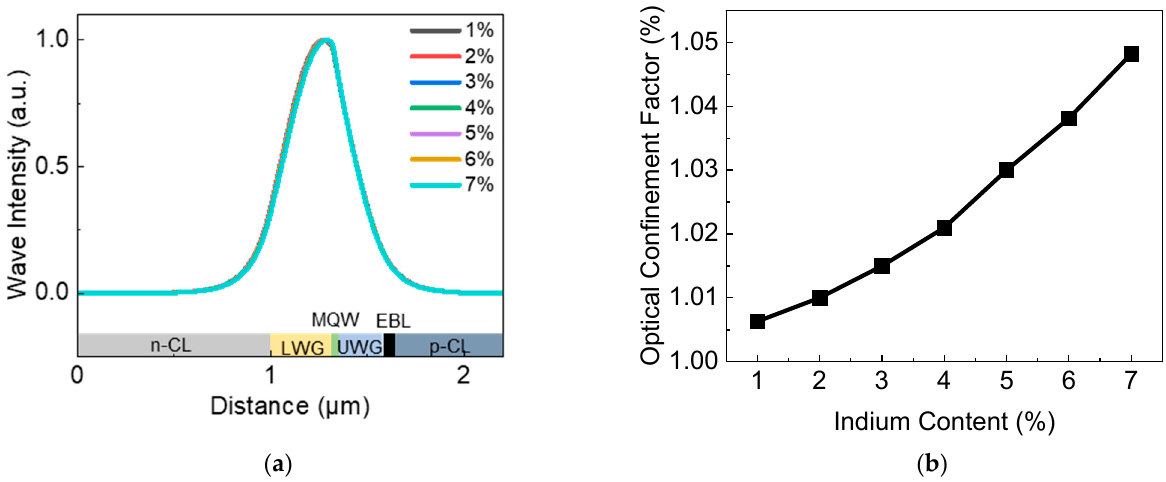
Figure 3. ( a ) Optical field distribution and ( b ) optical confinement factors versus indium content of quantum barriers.